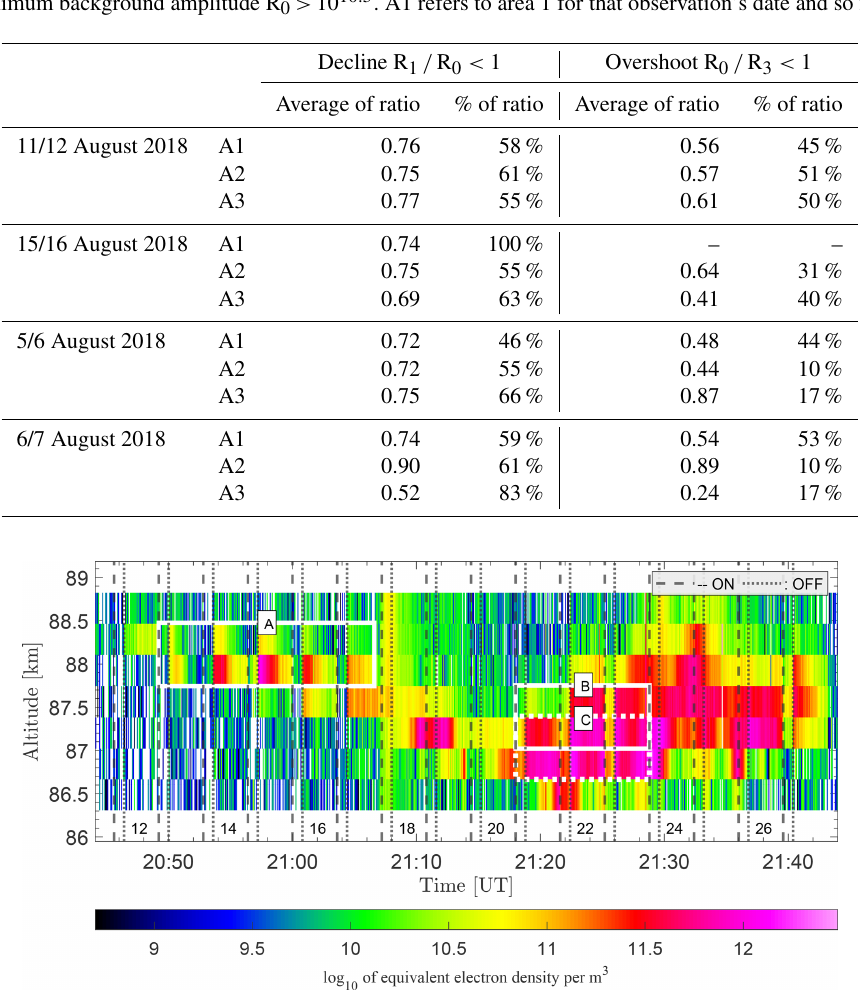
Table 2. Summary of histogram results (see histograms (Figs. S27–S36) in the Supplement) for the decline (R 1 / R 0 ) and the overshoot (R 0 / R 3 ) ratio when they are smaller than 1 (indicating heating effect and overshoot) for all four observations. These numbers only include observations with minimum background amplitude R 0 > 10 10 . 5 . A1 refers to area 1 for that observation’s date and so forth.